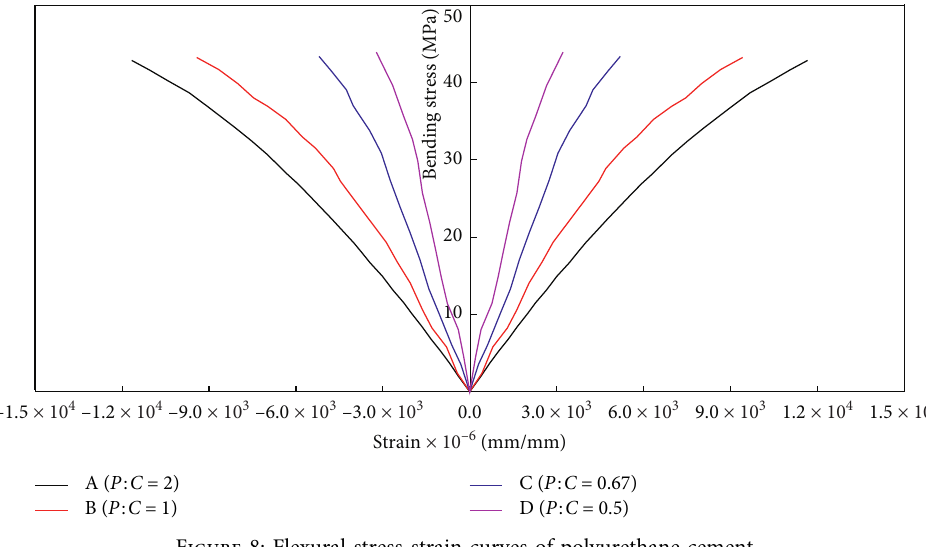
Figure 8: Flexural stress-strain curves of polyurethane cement.